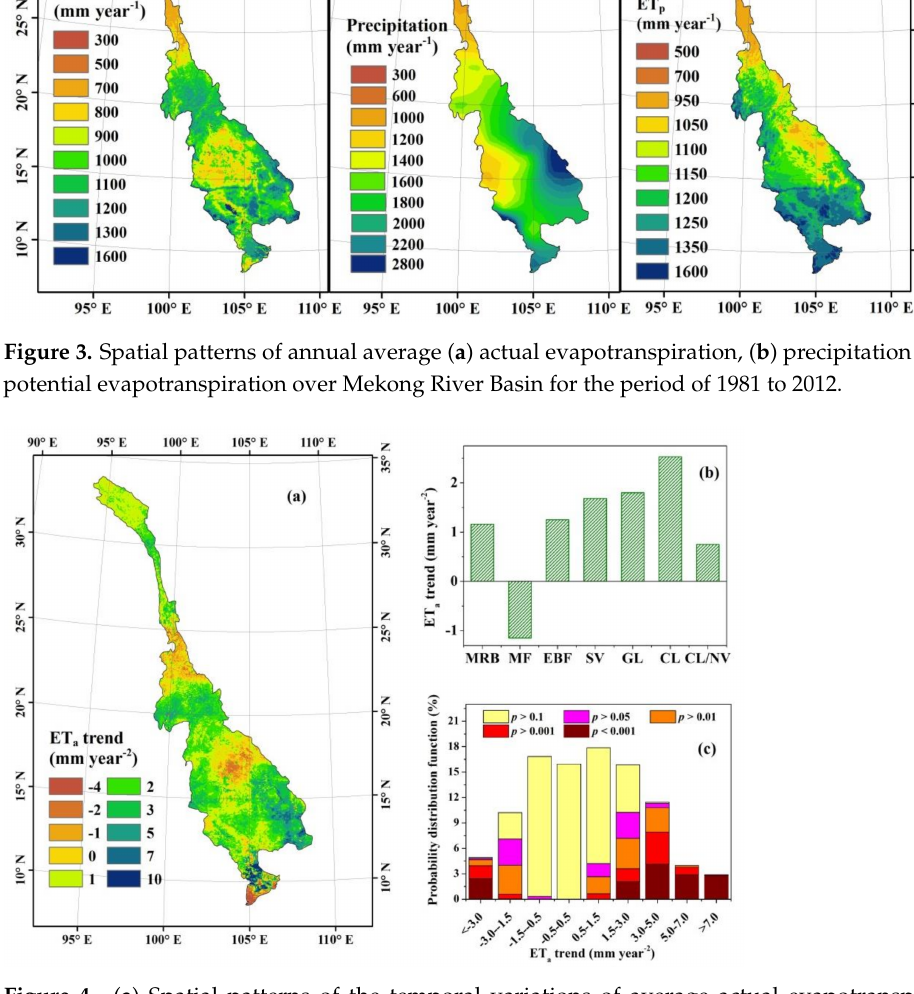
Figure 4. ( a ) Spatial patterns of the temporal variations of average actual evapotranspiration, ( b ) average change rate of actual evapotranspiration in different vegetation types, and ( c ) prob- ability distribution function of significant levels in the actual evapotranspiration